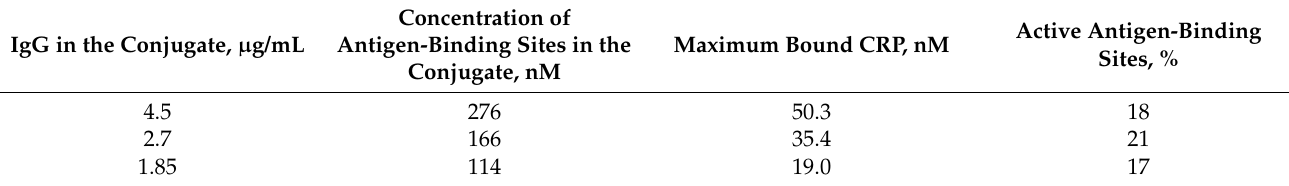
Table 5. Results of the study of the CRP binding by the GNP2–IgG conjugates. IgG in the Conjugate, µ